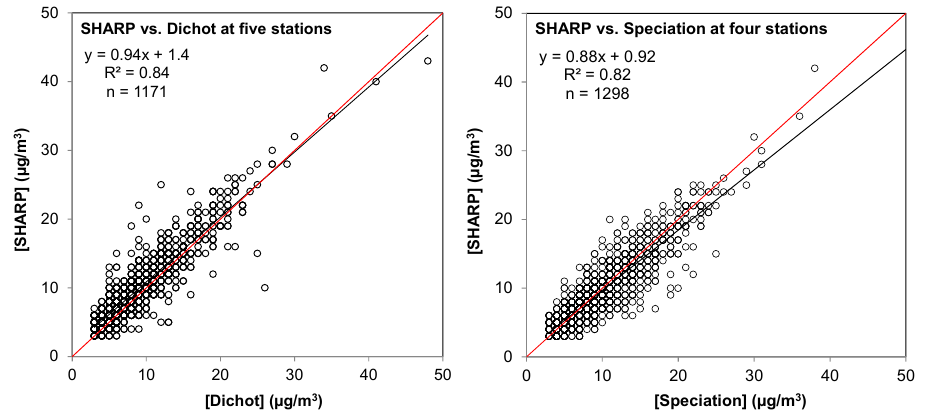
Figure 5. Correlations of 24 h PM 2.5 concentrations between the SHARP 5030 and the Dichot at five stations, as well as between the SHARP 5030 and the Speciation concentrations at four stations from the period of 2013–2016 (Dichot and Speciation in the figure refer to the Dichot and Speciation samplers). The SHARP 5030 collocated with both the Dichot and Speciation samplers at four select stations (Table 1). Annual averages of the SHARP 5030 were 11% (ranging from 7 to 18%) higher than those of the Dichot, and 7% (ranging from 3 to 16%) lower than those of the Speciation sampler (Figure